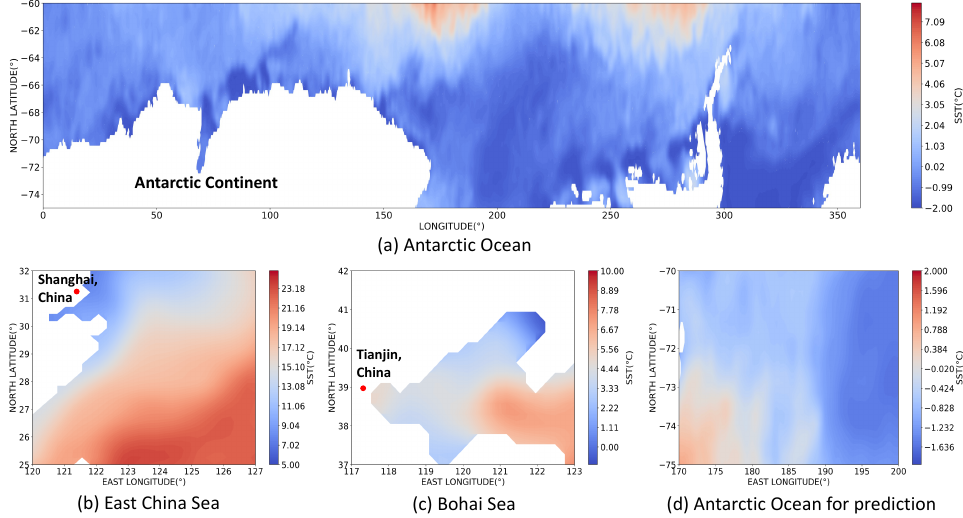
Figure 2. The monthly average SST in January 2002 for ( a ) Antarctic Ocean, ( b ) East China Sea, ( c ) Bohai Sea, and ( d ) the selected Antarctic Ocean area for